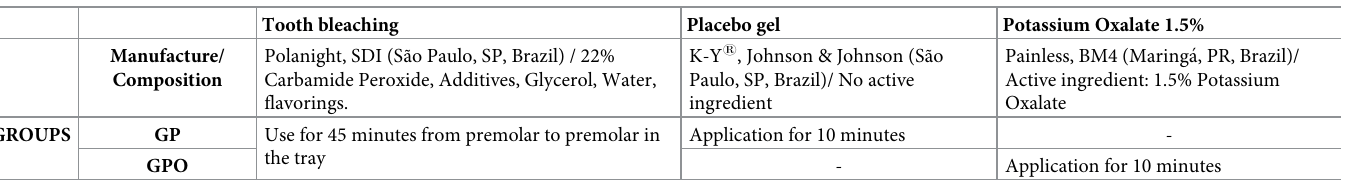
Table 1. Treatment used in different